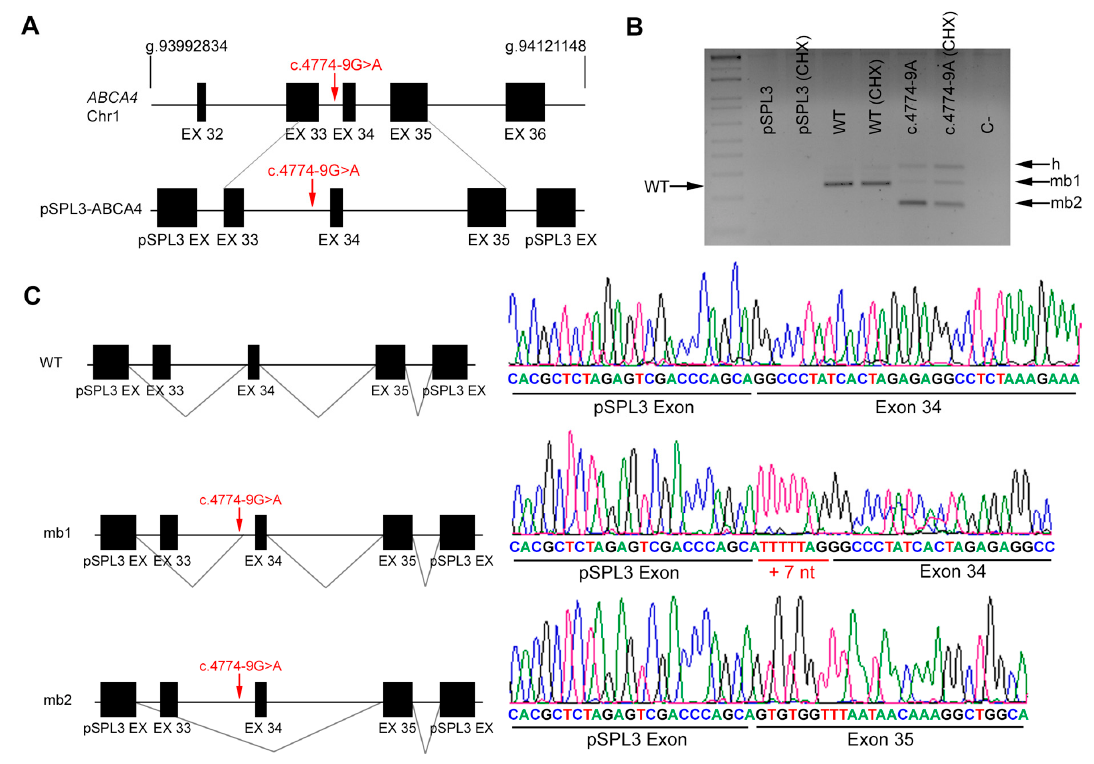
Figure 2. In vitro splicing analysis of the non-canonical splice site (NCSS) variant identified in ABCA4 in patient DBG1. ( A ) Genomic position of the identified NCSS variant in intron 33 of the ABCA4 gene (c.4774 -9G>A). Diagram showing the genomic region amplified from patient’s DNA, cloned into the pSPL3 vector. Note that exon 33 was not included in full. ( B ) Analysis of ABCA4 mRNAs from HEK293T cells transfected with either empty vector, WT or mutant genomic sequences (treated or untreated with cycloheximide, CHX). The band of 247 bp corresponds to the wild-type transcript (WT), whereas cells transfected with pSPL3 carrying the NCSS variant produced two different aberrant transcripts (mb1 and mb2). h indicates the heteroduplex band of mb1 and mb2. C- indicates the PCR negative control. ( C ) Subsequent Sanger sequencing of cloned individual bands (indicated in the left diagrams) and comparison to the wild-type transcript confirmed the insertion of 7 bp from intron 33 (mb1) due to acceptor splice site shift as well as exon skipping of exon 34